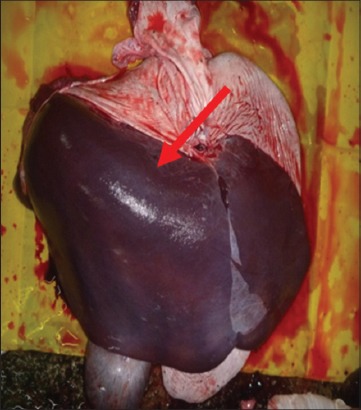
Congested and hemorrhagic liver.